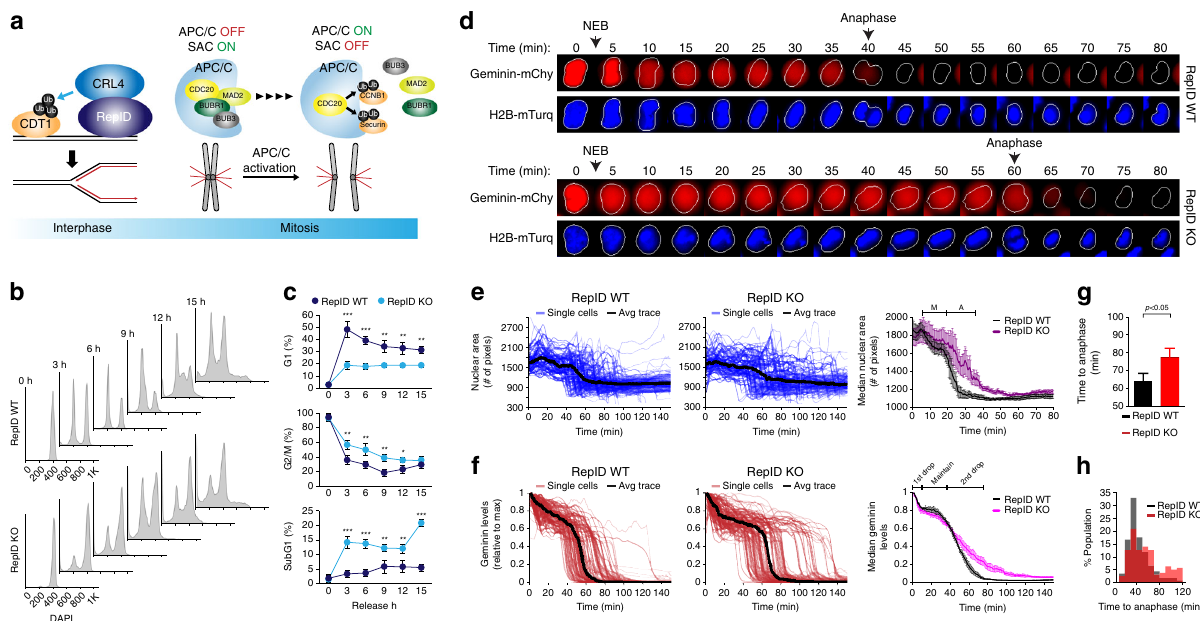
Fig. 1 Role of RepID in mitotic exit and G1 entry. a A model describing the current understanding of molecular interactions among components of the CRL4 and SAC complexes. b , c RepID KO cells delay mitotic exit. b HCT116 RepID WT and KO cells were exposed to nocodazole for 16 h, released into drug-free media, and collected every 3 h, followed by fl ow cytometry to monitor cell cycle progression. c Percentages of cells from b in G1, G2/M, and subG1 fractions for the experiment shown in b . Error bars in all results represent standard deviation from three independent experiments (* p value < 0.05, ** p < 0.01, *** p < 0.001, Student ’ s t test). d – h RepID KO cells exhibit prolonged metaphase – anaphase transition. d Image montage of a representative single cell expressing APC-degron (mCherry-geminin) and H2B-mTurquiose in HCT116 RepID WT and KO cells after release from CDK1 inhibitor-based synchronization. Images were taken every 5 min. NEB, nuclear envelop break. e Single-cell traces of the intensity of nuclear area in RepID WT and KO cells. The black line illustrates the average trace (left and middle panels). The fi rst drop indicates a reduced area due to chromosome alignment in metaphase and the second drop indicates the segregation of chromosomes via the initiation of anaphase (right panel) (M metaphase, A anaphase). f Single-cell traces of APC-degron in RepID WT and KO cells. Black line illustrates the average trace (left and middle panels). The fi rst drop indicates nuclear envelope breakdown (right panel). The constant APC-degron signal indicates a period prior to anaphase initiation. The second drop indicates anaphase initiation (right panel). g Bar graph indicates time to anaphase from release. h Percentage of anaphase cells in the population after release from nocodazole arrest in HCT116 RepID WT and KO